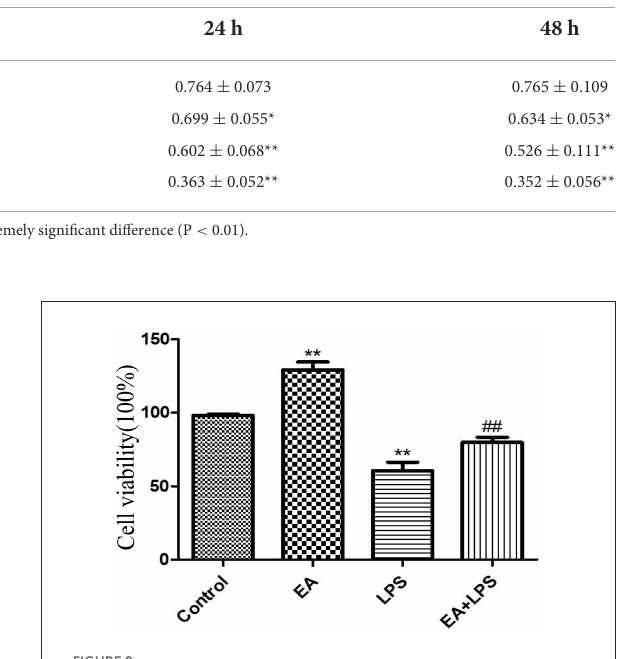
FIGURE9 The effect of ellagic acid on LPS-induced IPEC-J2 inflammatory cell viability. Compared with the control group, **